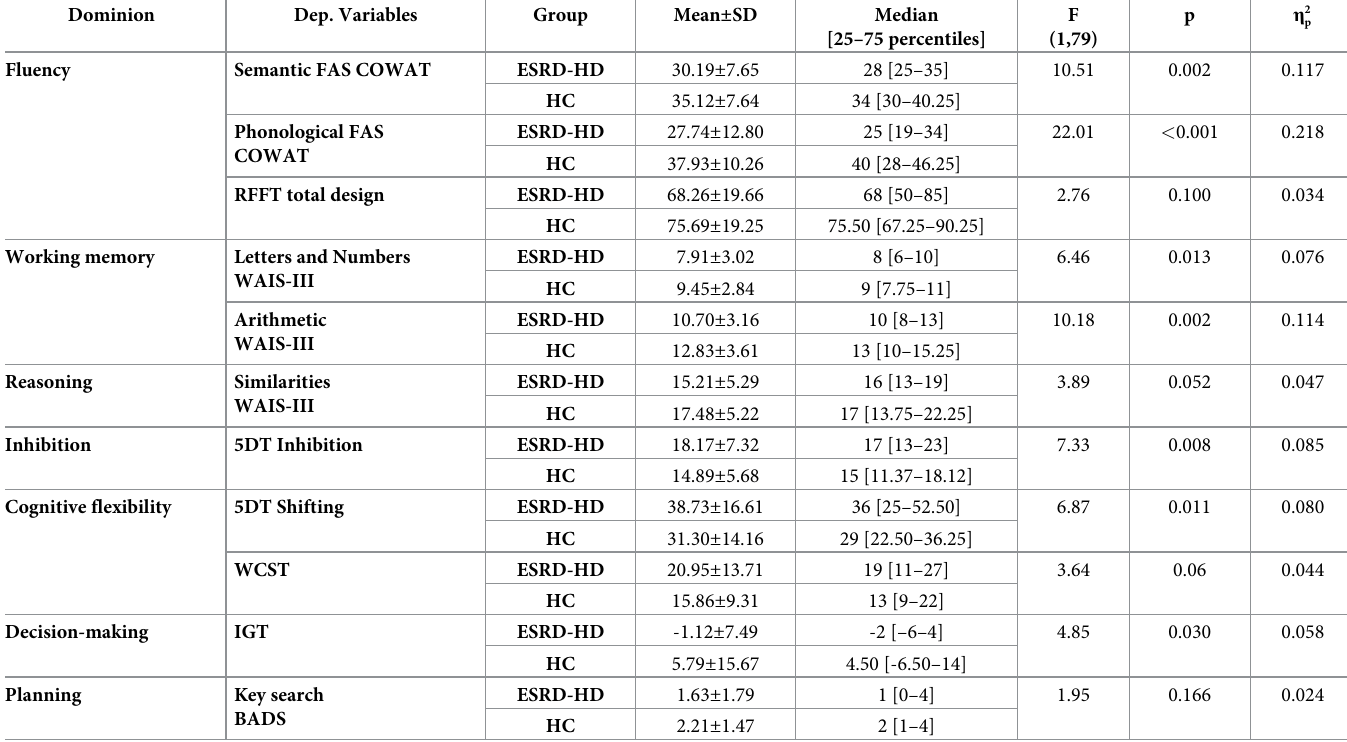
Table 3. Means (±SD), median, and 25 th and 75 th percentiles of neuropsychological variables for the two groups in the pre-HD evaluation.